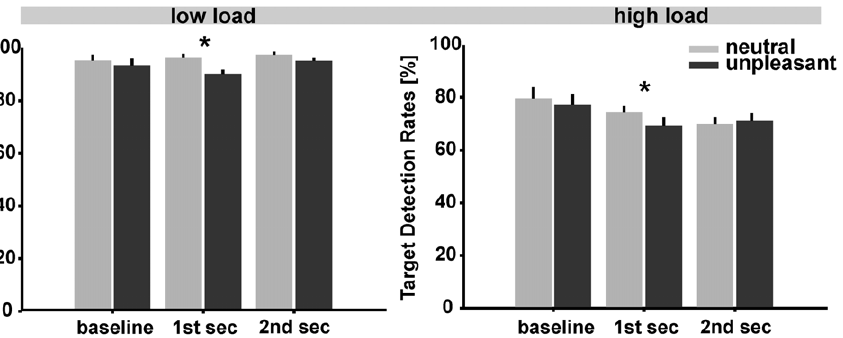
Figure 2. Target detection rates. Mean target detection rates in percent and corresponding standard errors for 3 successive time windows of one second each (at baseline before picture change, 1 st second and 2 nd second after picture change) averaged across all subjects for neutral (light gray bars) and unpleasant pictures (dark gray bars), separately for low load and high load conditions.